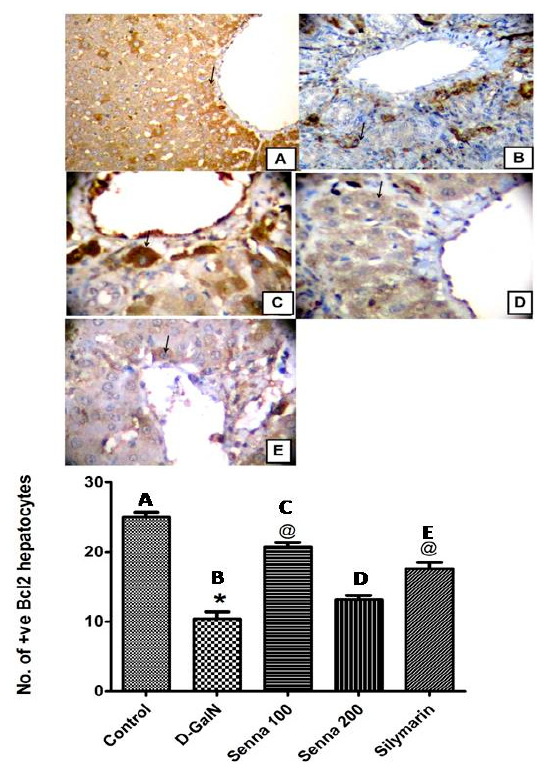
Figure 7. Bcl-2 expression measured by immunohistochemistry in paraffin-embedded liver tissues and stained with Avidin-biotin peroxidase stain with haematoxylin counter stain, original magnification (400 × ). ( A ): A liver section of an adult rat of control group showing strong positive cytoplasmic Bcl-2 immunoreaction (arrow); ( B ): A liver section of an adult rat of D -GalN group, showing weak cytoplasmic immunoreaction for Bcl-2 (arrow); ( C ): A liver section of an adult rat pre-treated with the bark extract (100 mg/kg) followed by D -GalN showing strong positive cytoplasmic immunoreaction for Bcl-2 (arrow); ( D ): A liver section of an adult rat pre-treated with the bark extract (200 mg/kg) followed by D -GalN group showing moderate cytoplasmic immunoreaction for Bcl-2 (arrow); ( E ): A liver section of an adult rat pre-treated with silymarin (100 mg/kg) followed by D -GalN showing moderate cytoplasmic immunoreaction for Bcl-2 (arrow). Five fields per group were randomly selected and analysed. Graph included with the images reveals morphometric analysis for the mean number of hepatocytes for each corresponding group which are positive to Bcl-2; statistical difference was detected using One Way ANOVA followed by Tukey’s post hoc test. * Significantly different from control group at p < 0.05, @ Significantly different from D -GalN group at p <